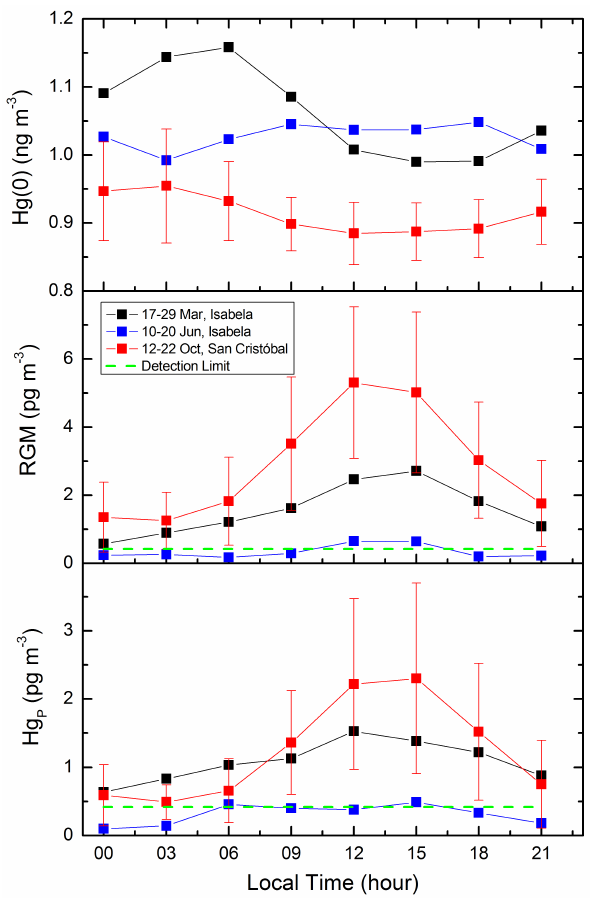
Fig. 5. Relationship between daily averaged concentrations of Hg(0) in the MBL and sea surface chlorophyll a (A) and temper- ature (SST) (B)